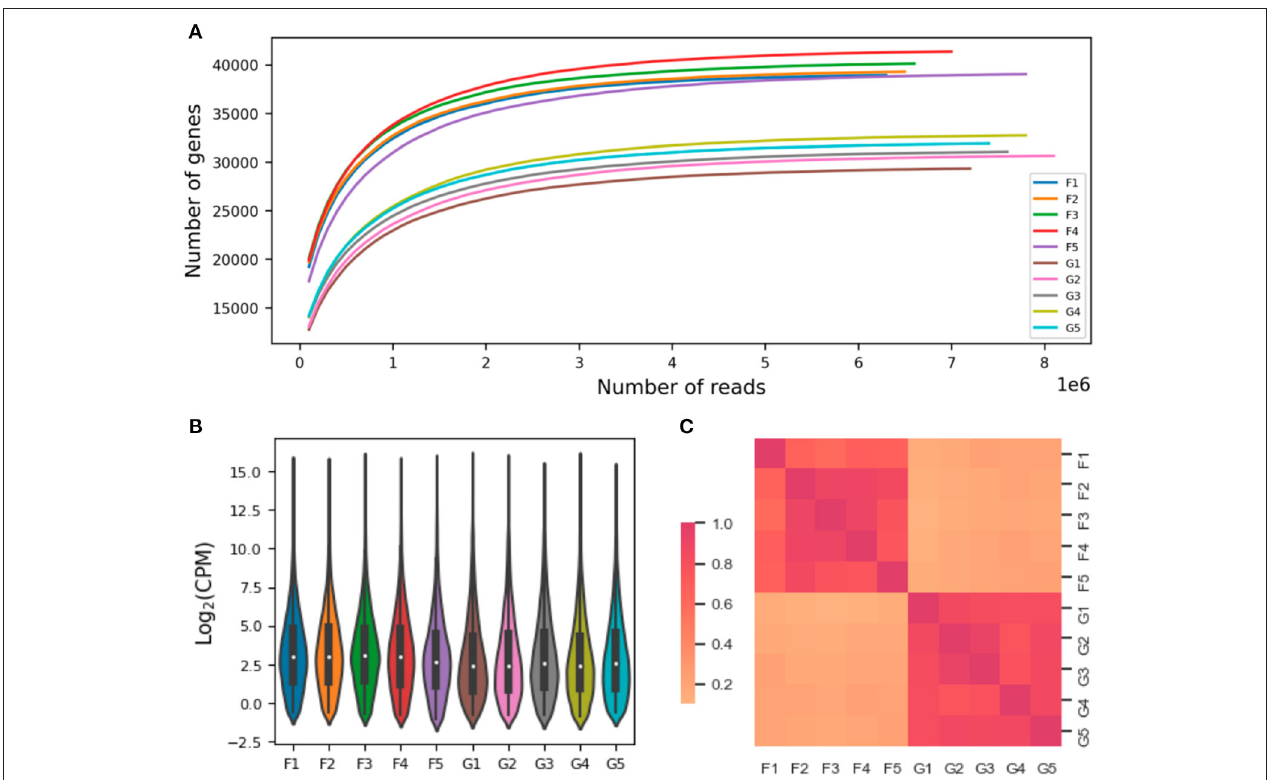
FIGURE 2 | Quantification of gene expression. The individual rarefaction curves indicate relationship between the sequencing depth and number of genes observed (A) . The overall distribution of gene expression levels and pairwise Pearson correlations of sequenced samples are shown in (B, C) , respectively. The sample names were denoted by prefix of “F” and “G” for lung and liver issues, respectively; such as, the “F1” denotes the sequenced lung issue for the first animal. CPM, counts per million mapped